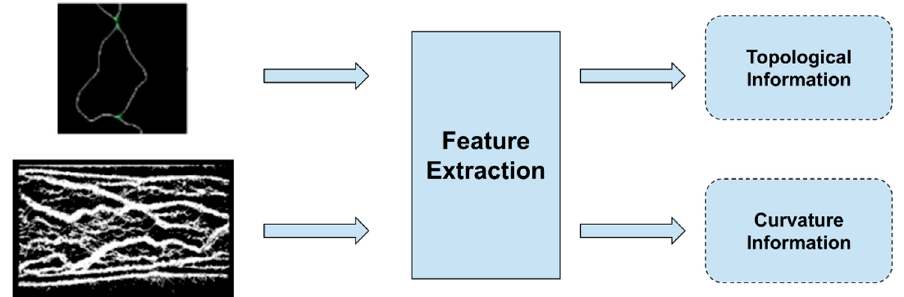
Figure 4. Typical extraction of information relative to the vein patterns.